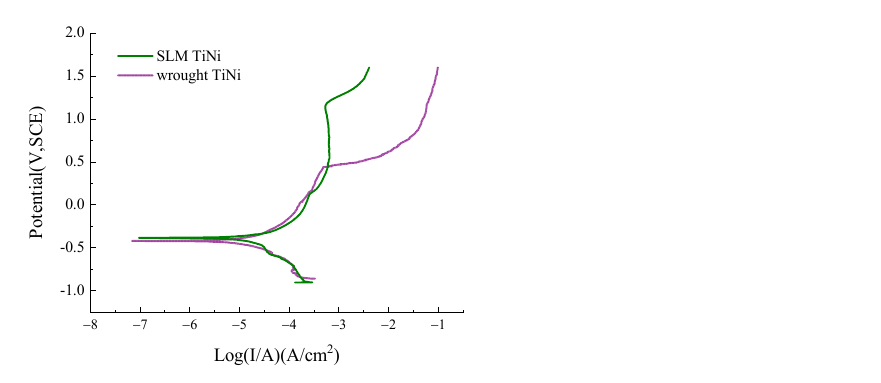
Figure 8. ASS polarization curves of SLM and wrought TiNi samples in 0.5% F − ASS at pH 4. Table 3. Potentiodynamic polarization corrosion parameters of SLM and wrought TiNi samples in 0.5% F − ASS at pH 4.